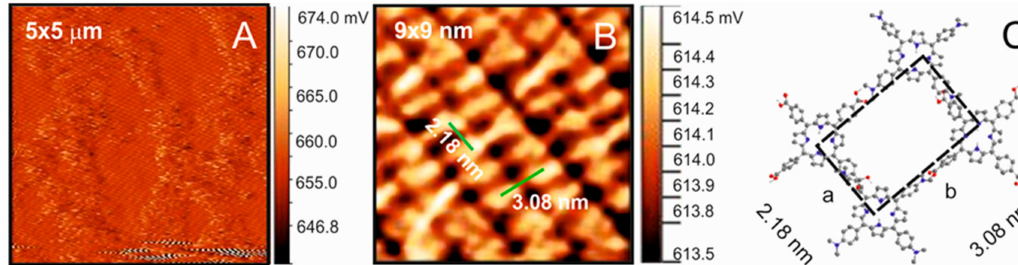
Figure 5. ( A ) Low-resolution AFM image of the assembly on the gold substrate. ( B ) High-resolution AFM image at 9 nm 2 showing the arrangement of the TDAP-TCPP assembly. On the x-axis, the distance is 2.18, and on the y-axis it is 3.08 nm, measured in the areas marked with green lines. ( C ) Top view of the proposed structural model for the TDAP-TCPP